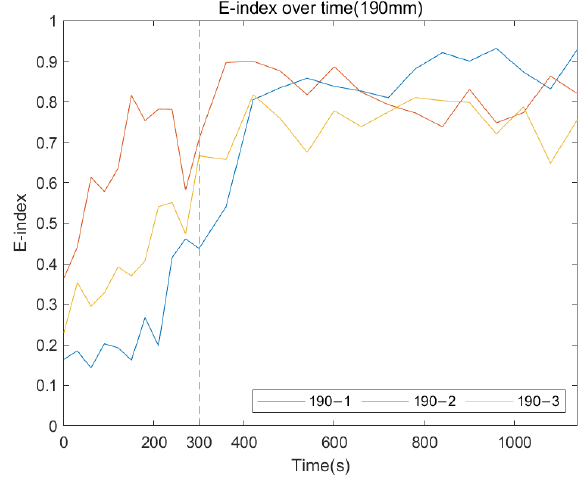
Figure 15. E ‐ index development as the function of cure time for 190 mm.